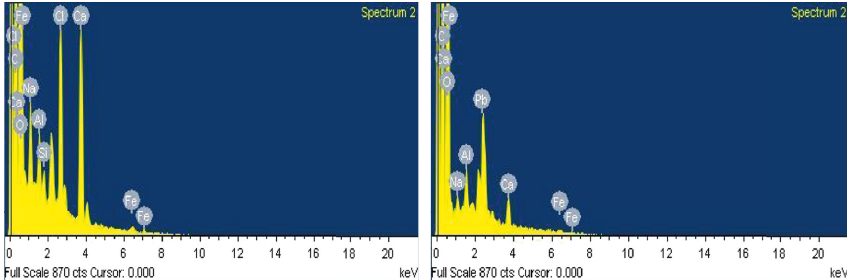
Figure 4: EDX spectra of adsorbent (HRMCAB) before and after adsorption of lead.